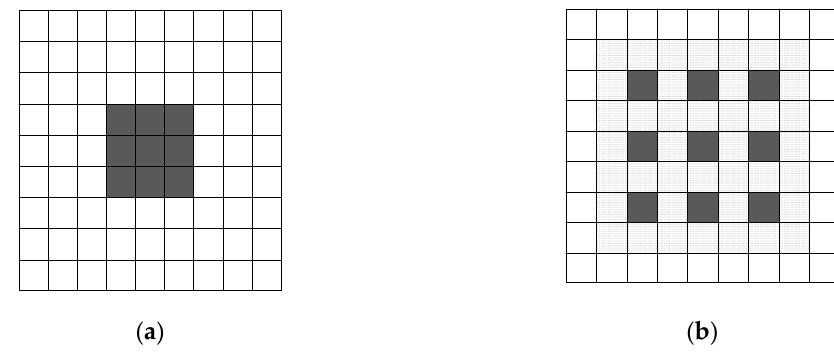
Figure 1. Convolution with kernel size 3 × 3 and different rates. ( a ) Standard convolution corresponds to atrous convolution with rate = 1. ( b ) Employing large value of atrous rate enlarges the model’s field-of-view, rate = 2.